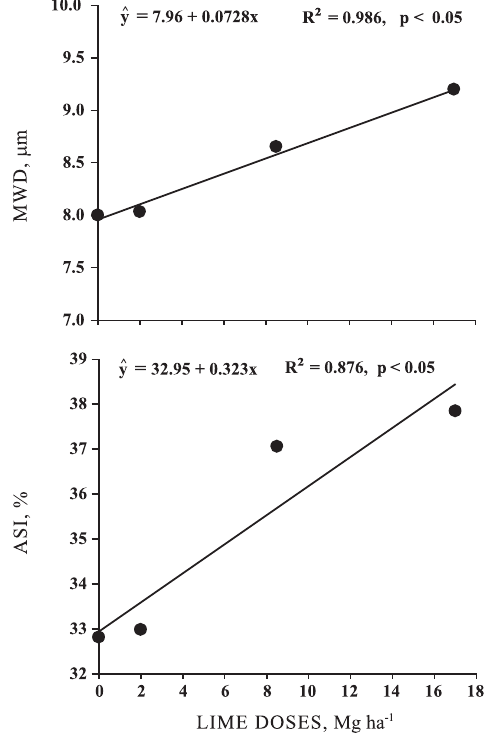
Figure 2. Mean values of the Mean Weighted Diameter (MWD) and the Aggregate Stability Index (ASI) from aggregates between 1 and 2 mm of an Acrisol at 0–0.05 m of depth as a function of doses of incorporated lime. Each value represents the mean of six stress levels in LD and two lime